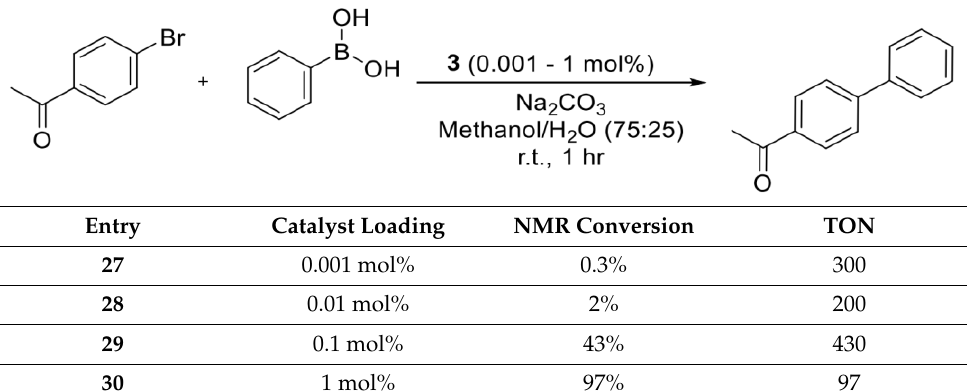
Table 4. Results from the catalytic loading screen with NMR conversion and calculated TON from the conversion.